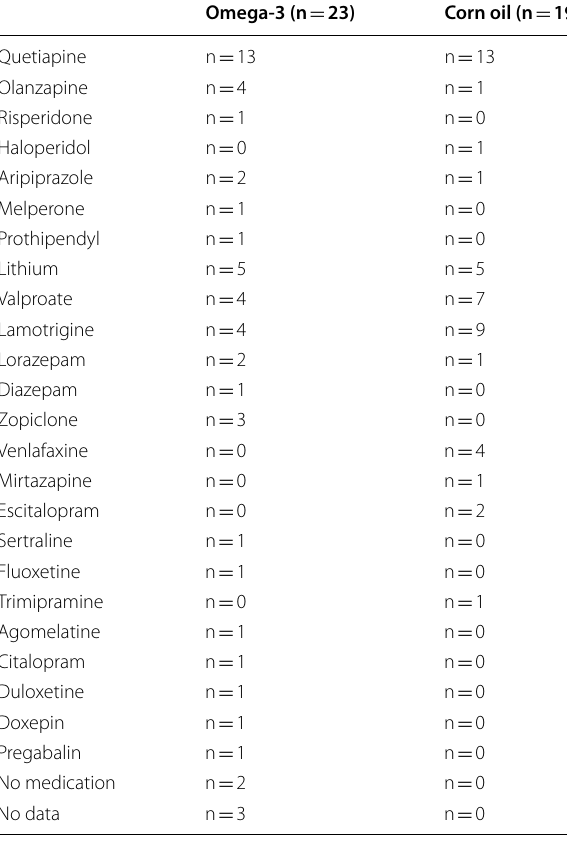
Table 2 Psychotropic medication Table 3 Standardized rating scales endpoint and change from